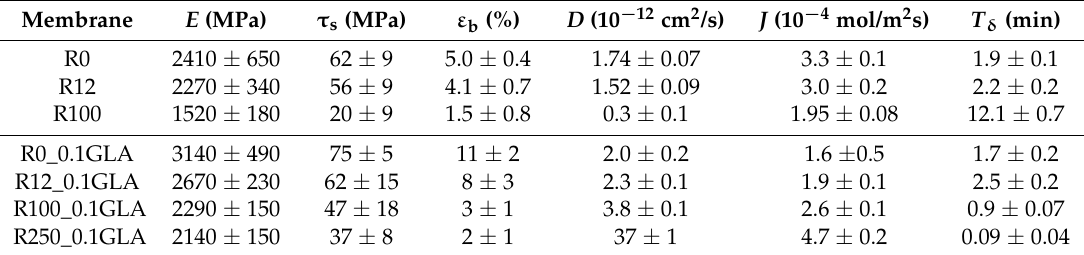
Table 2. Mechanical properties (Young’s modulus, E ; tensile strength, τ S ), and transport parameters (diffusion coefficient, D ; molar flux, J ; time lag, T δ ) of the membranes prepared with non-irradiated and irradiated chitosan at different doses, without and with 0.1 wt % GLA in the chitosan solution. The drug permeability tests were carried out using 15 g/L SULF aqueous solution.